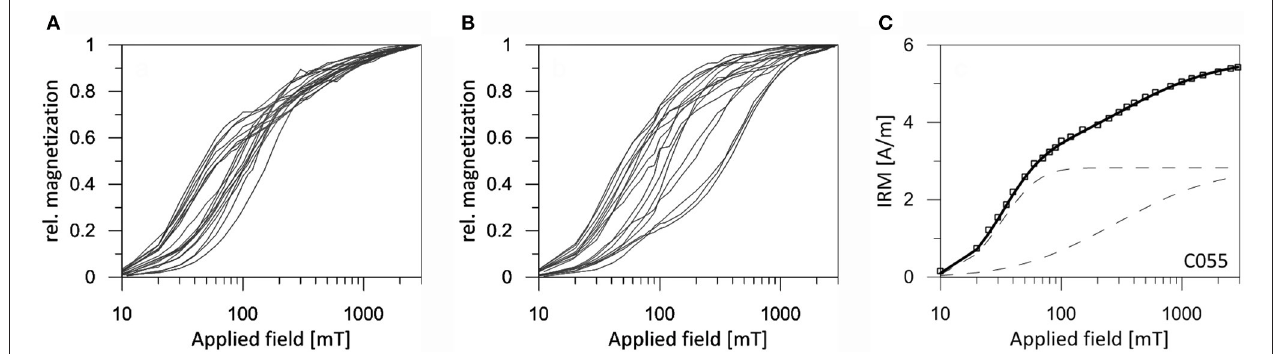
FIGURE 7 | Isothermal remanence magnetization acquisition curves: (A) alluvial fan and dry mudflat facies types, (B) wet mudflat facies type, (C) end member modeling for sample C055 (dry mudflat facies type) after Kruiver et al. (2001) with the two end member components magnetite and hematite indicated with dashed lines.